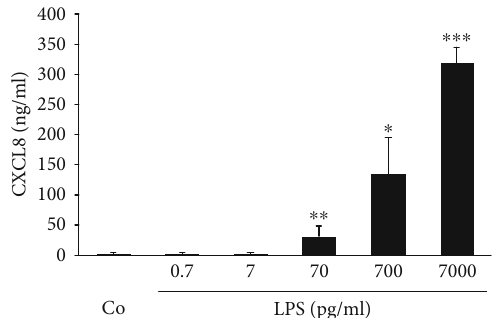
Figure 6: Low concentrations of LPS induce CXCL8 in CD14 + monocytes. Human CD14 + monocytes derived from bu ff y coats from healthy donors were stimulated with LPS (0.7-7000 pg/ml) or were left untreated (Co). After 24 h, supernatants were collected and levels of CXCL8 were determined via a speci fi c ELISA. Data represent the mean production of CXCL8 ± SEM derived from 3 to 11 independent experiments. Statistically signi fi cant di ff erences from untreated control cells, determined by the Mann-Whitney U test, are indicated by asterisks ( ∗ p < 0 : 05 ; ∗∗ p < 0 : 01 ; ∗∗∗ p < 0 : 001 ). Figure 7: In contrast to impure mu rSAA3, RP-HPLC-puri fi ed mu